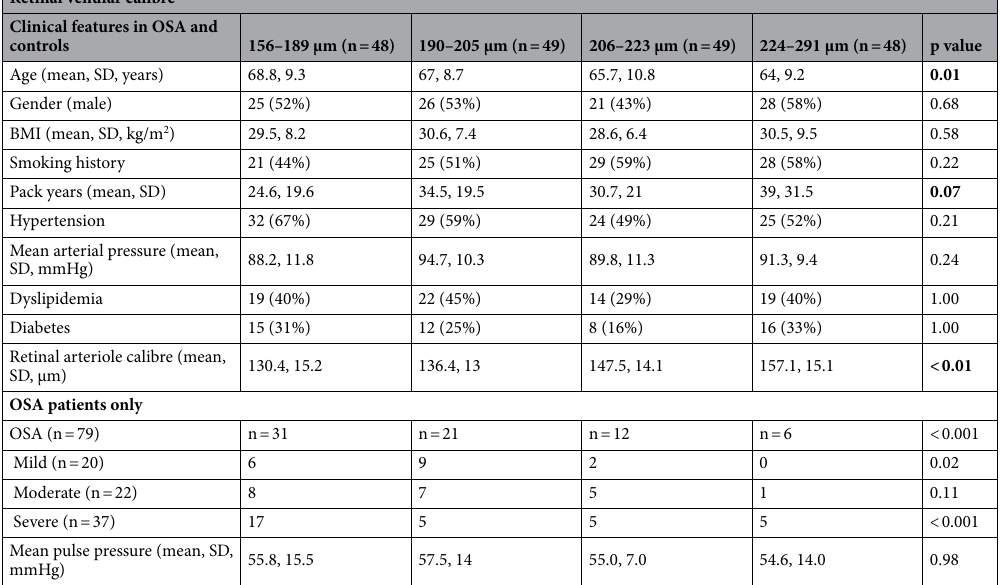
Table 4. Clinical features and retinal venular calibre in OSA plus hospital controls by quartile. Smaller retinal venular calibre was associated with an older age (p = 0.01), a smaller arteriole calibre (p < 0.01), and there was a trend with fewer pack years (p = 0.07). In patients with OSA only, all OSA was associated with a smaller venular calibre (p < 0.001). Mild and severe OSA were associated with a smaller venular calibre (p = 0.02, p < 0.001 respectively). Retinal venular calibre was not associated with mean pulse pressure (p = 0.98). Significant values are in bold.